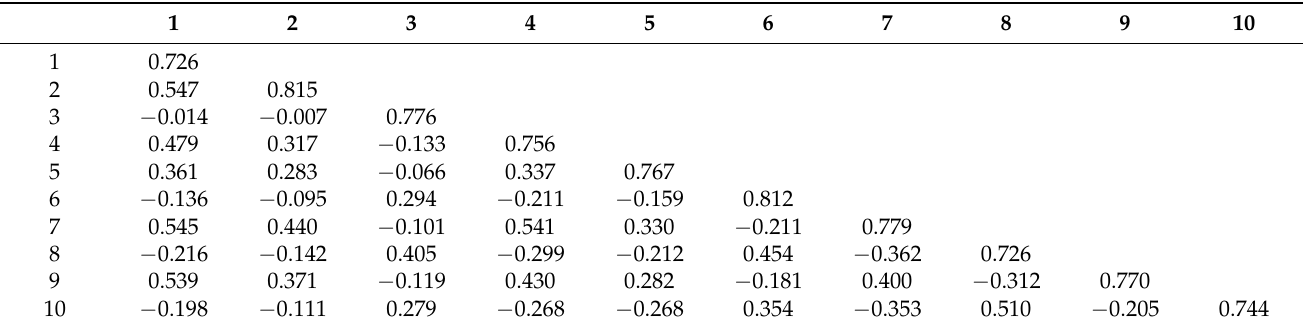
Table 2. The construct of discriminant validity.